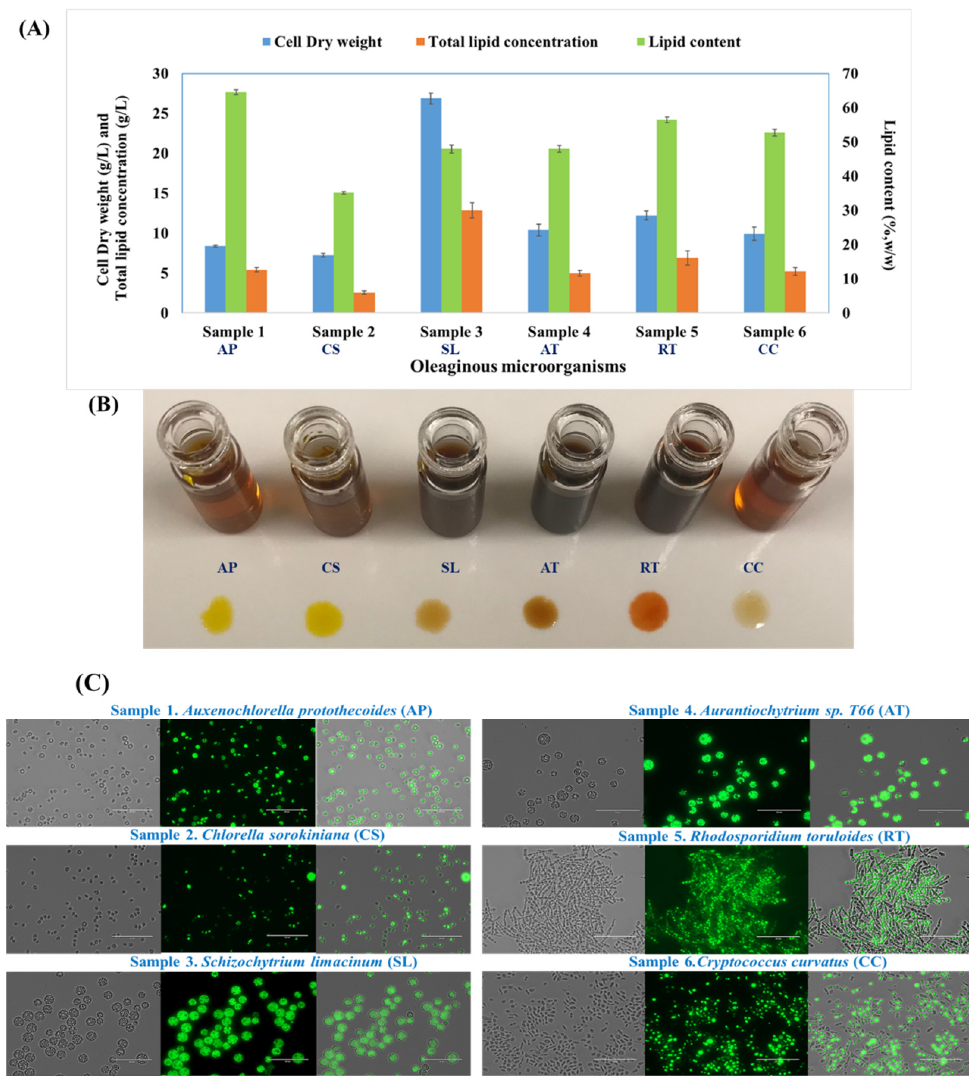
Figure 1. ( A ) Biomass and lipid accumulation from oleaginous microalgae A. protothecoides (AP) and C. sorokiniana (CS); thraustochytrids S. limacinum (SL) and Aurantiochytrium sp. T66 (AT); and yeasts R. toruloides (RT) and C. curvatus (CC). ( B ) Lipids were extracted from the corresponding microorganisms mentioned in panel A. ( C ) Fluorescence micrographs showing the morphology and lipid accumulation in oleaginous microorganisms.